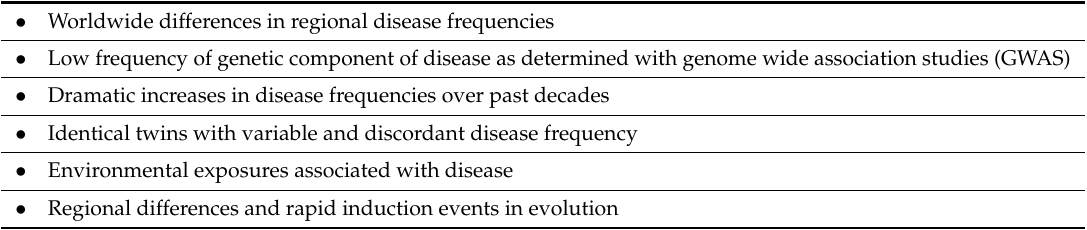
Table 1. Environmental epigenetic impacts on biology and